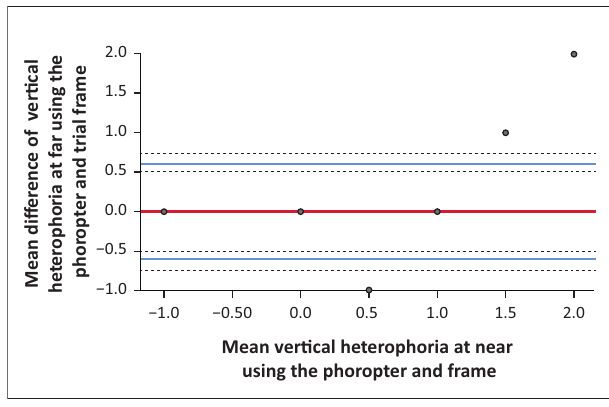
The 95 % limits of agreement are shown with blue lines and 95 % CI around limits of agreement are shown using dotted lines. Units are in prism dioptres. FIGURE 9: Bland-Altman plot for mean difference (red line) between the vertical heterophoria measured at distance vision using the phoropter and trial frame.